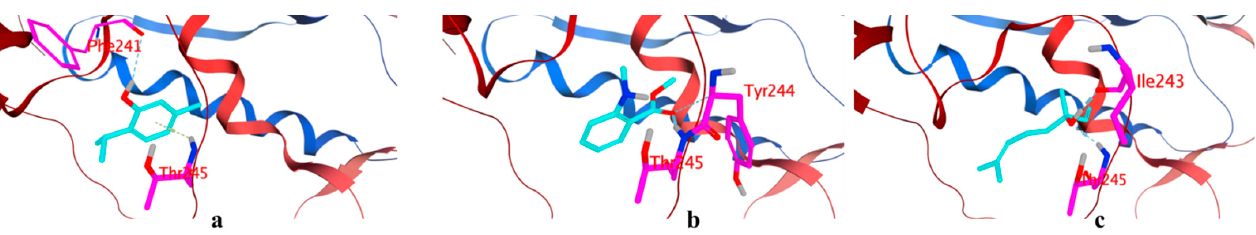
Figure 4. Binding modes of thymol ( a ), dimethyl anthranilate ( b ), and linalool ( c ) with hyaluronidase.